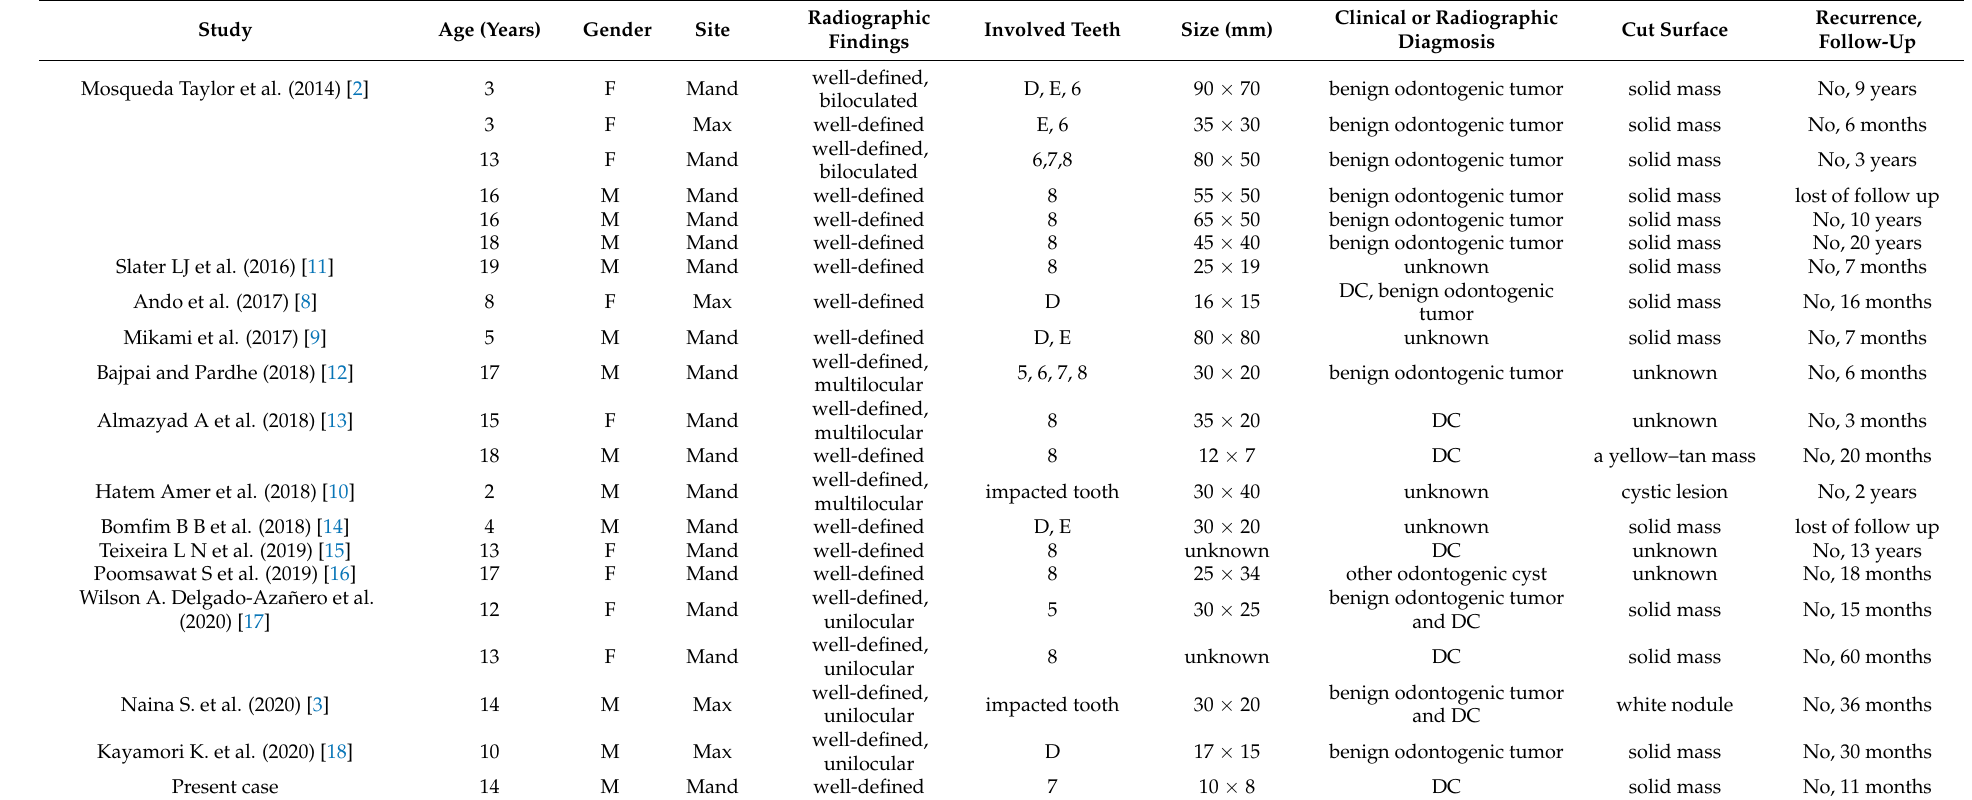
Table 1. Previous report of primordial odontogenic tumor